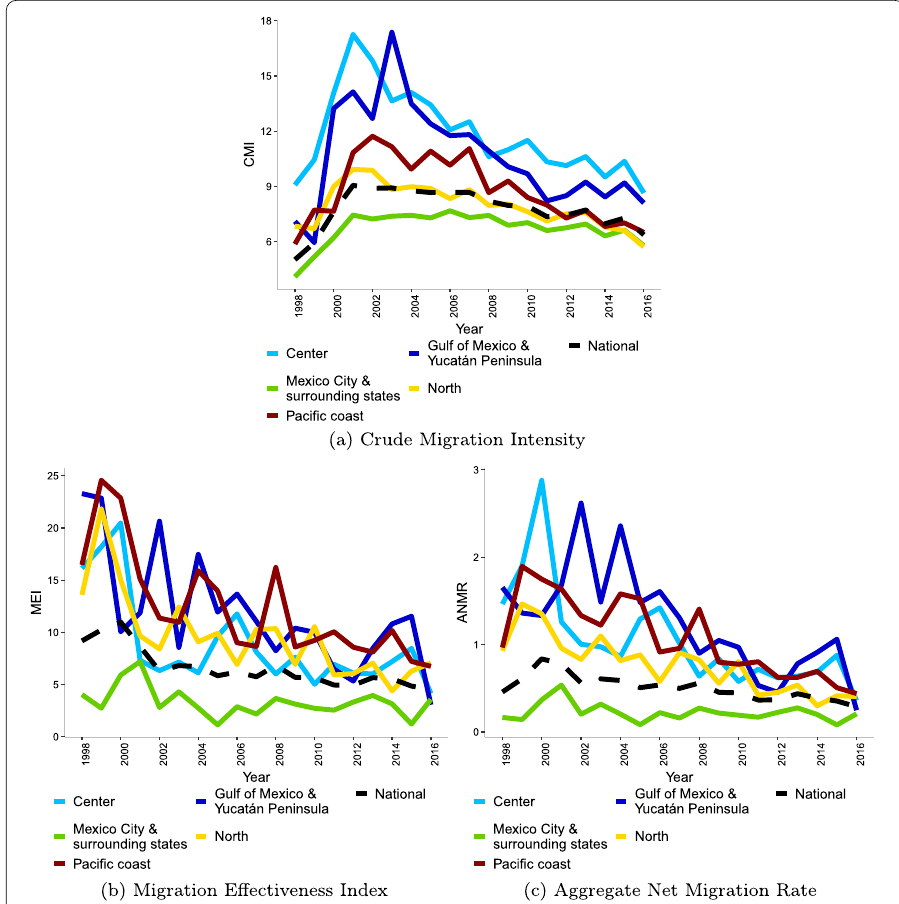
Figure 8 Migration intensity indices, over time. Dashed line represent country indices